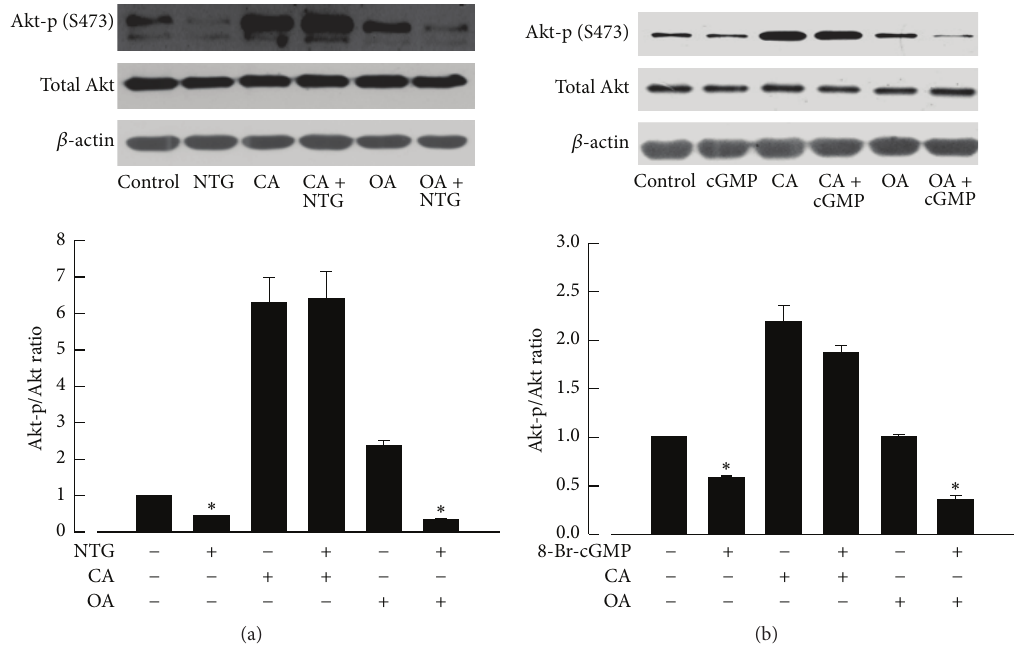
Figure 4: Effects of calyculin A and okadaic acid on the decrease in protein levels of Akt-p (S473) caused by NTG and 8-Br-cGMP. Akt-p (S473) was reduced when treated with NTG (10 −6 M; (a)) for 15 min and 8-Br-cGMP (cGMP analog, 10 −4 M; (b)) for 60 min. The reduction of Akt-p (S473) was prevented by calyculin A (CA, 10 −7 M) but not by okadaic acid (OA, 10 −7 M). The upper panels are western blots. The lower panels are the summaries of densitometric scanning of proteins expressed as ratio of Akt-p (S473) to total Akt. Data shown as means ± SEM; 𝑛 = 6 for each group. ∗ significantly different from the control group ( 𝑃 < 0.05